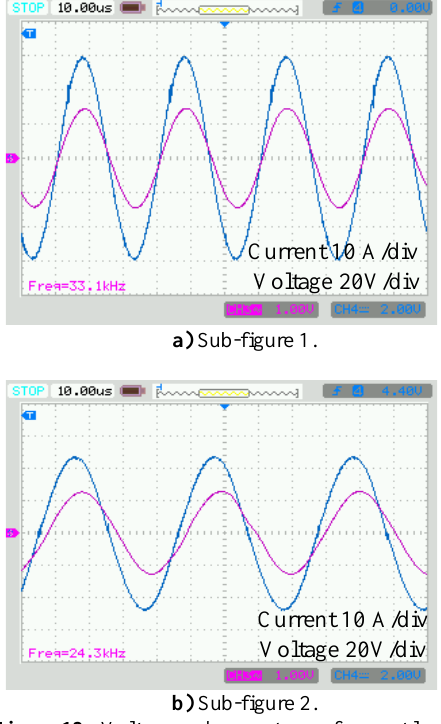
Figure 13. Voltage and current waveforms at load resistance (RL ) for scenario III (a) performance of PSO algorithm (b) performance of PO algorithm.